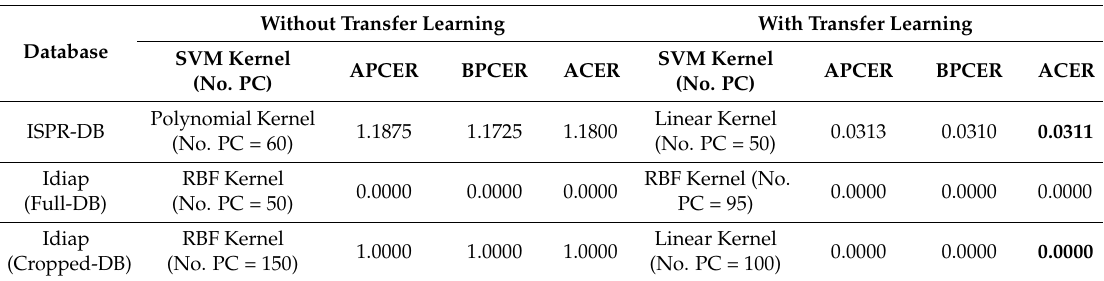
Table 12. Detection errors of our proposed method with and without applying the transfer learning technique using Alex network architecture in Table 2 (unit: